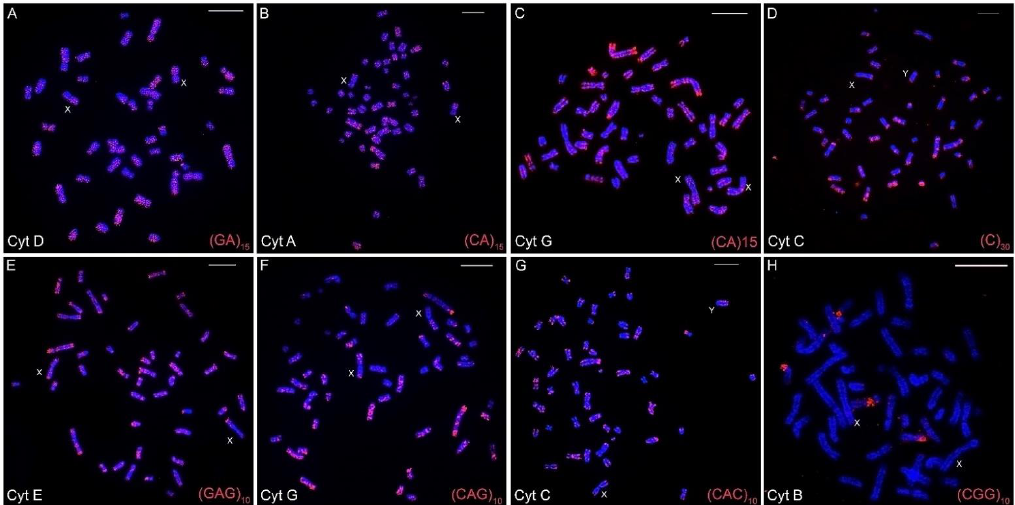
Figure 2. Fluorescence in situ hybridizations with varied microsatellites motifs in the different cytotypes ( A – H ) of Ctenomys minutus . The sex chromosomes are indicated for each metaphase. Bar = 10 μm .